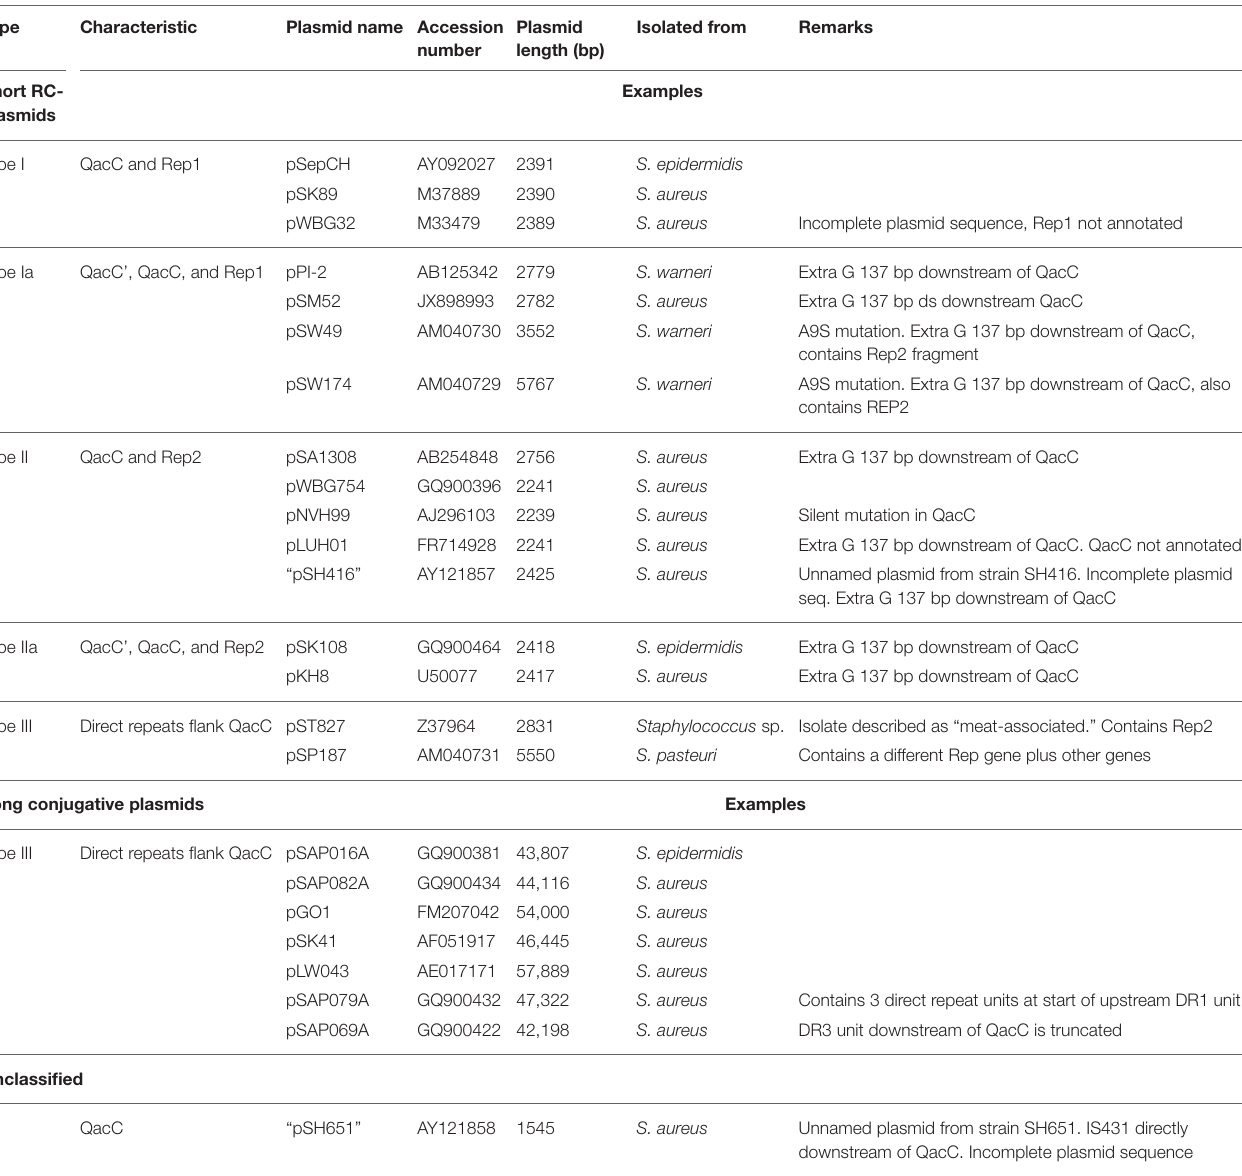
TABLE 1 | Plasmids containing QacC used in the